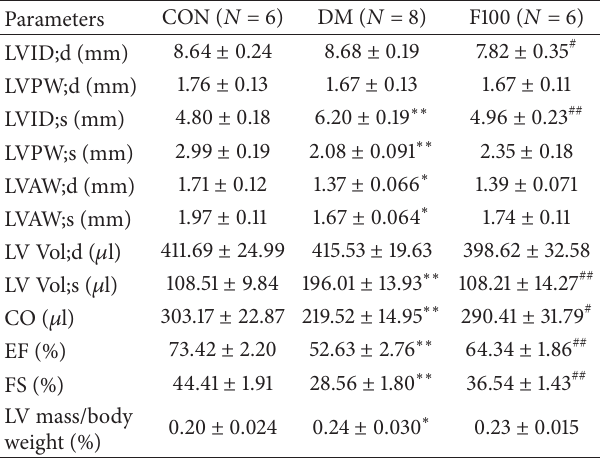
Table 1: Echocardiographic parameters of rats from different